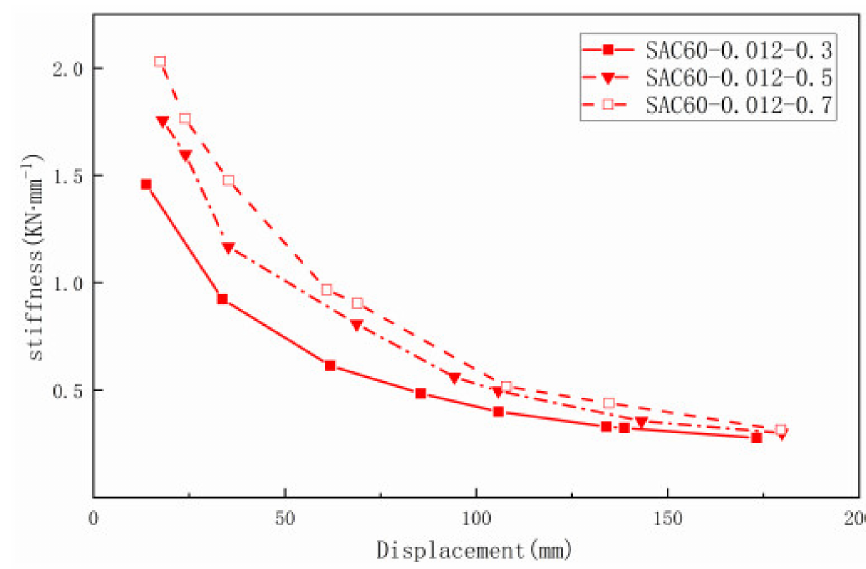
Figure 19. Relationship between stiffness degradation and